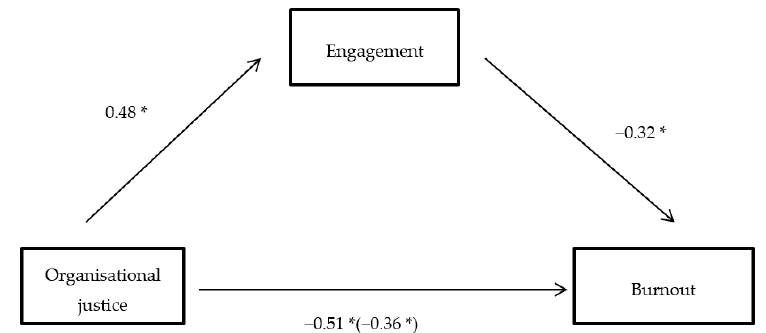
Figure 2. Engagement mediating effect between the organisational justice and burnout variables. (*) p < 0.001; (c) [beta] is obtained from the analysis, considering both organisational justice and engagement.